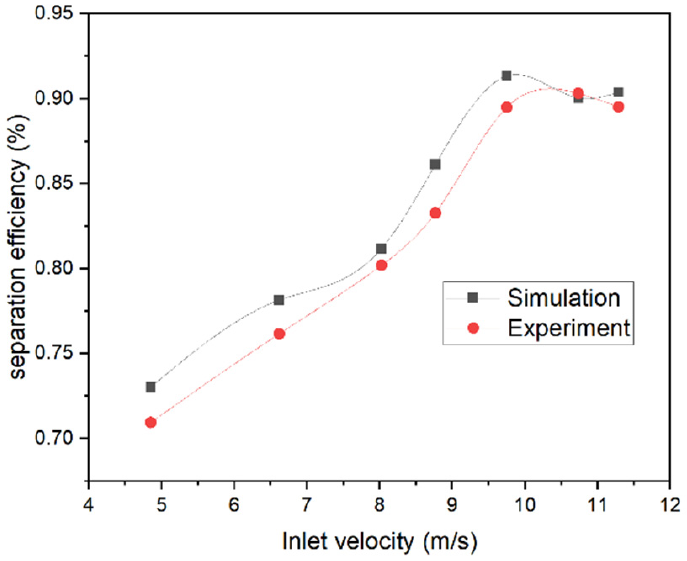
Figure 5. Comparison chart of separation efficiency between simulation and experiment.